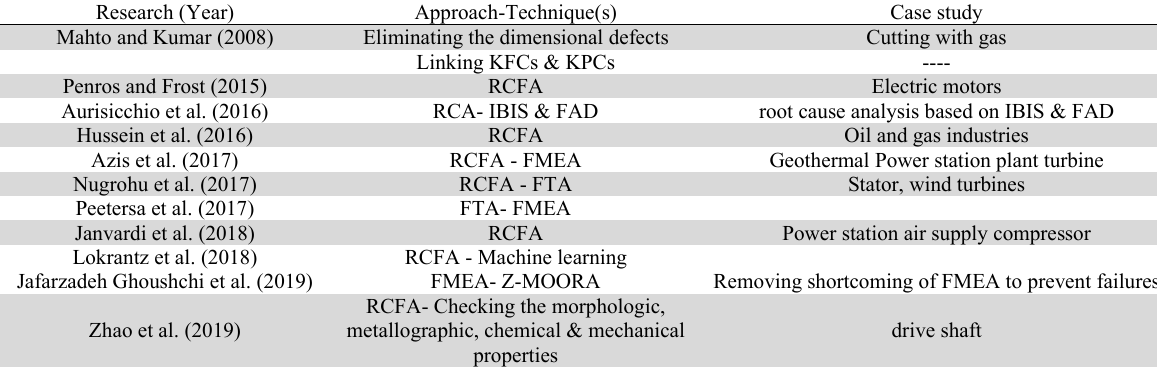
A review of some published